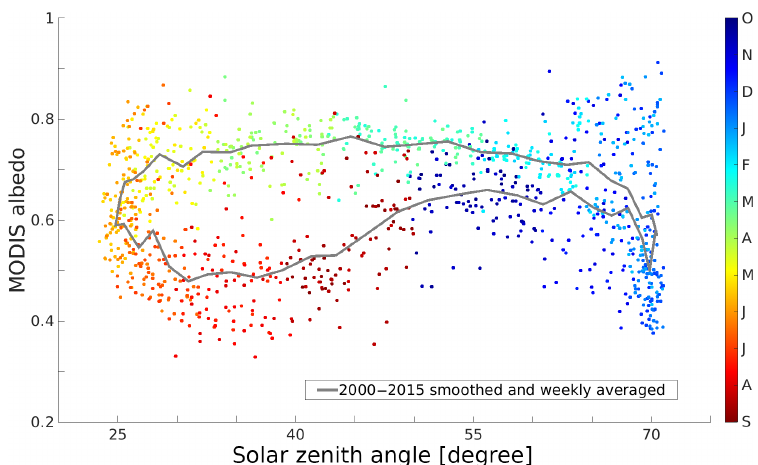
Figure 5. Albedo cycle for Argentière Glacier as a function of the SZA. Each point corresponds to glacier-wide averaged albedo for each available image. The 16 years are displayed. Colour scale gives indication on the date of the used image. The thick grey line describes the weekly albedo averaged over the entire study period. For readability purpose, the averaged albedo has been smoothed, using a seven-point running average.